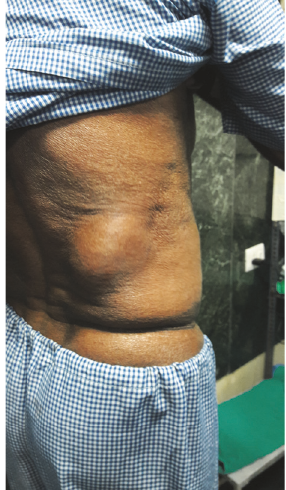
Figure 3: Defect delineated after excision of the protruding retroperitoneal fat.